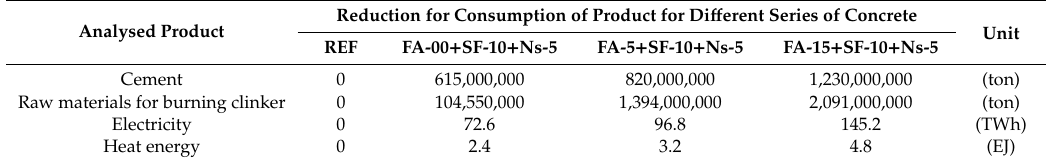
Table 4. Reduction of the annual consumption of products when replacing the OPC with three additives. Analysed